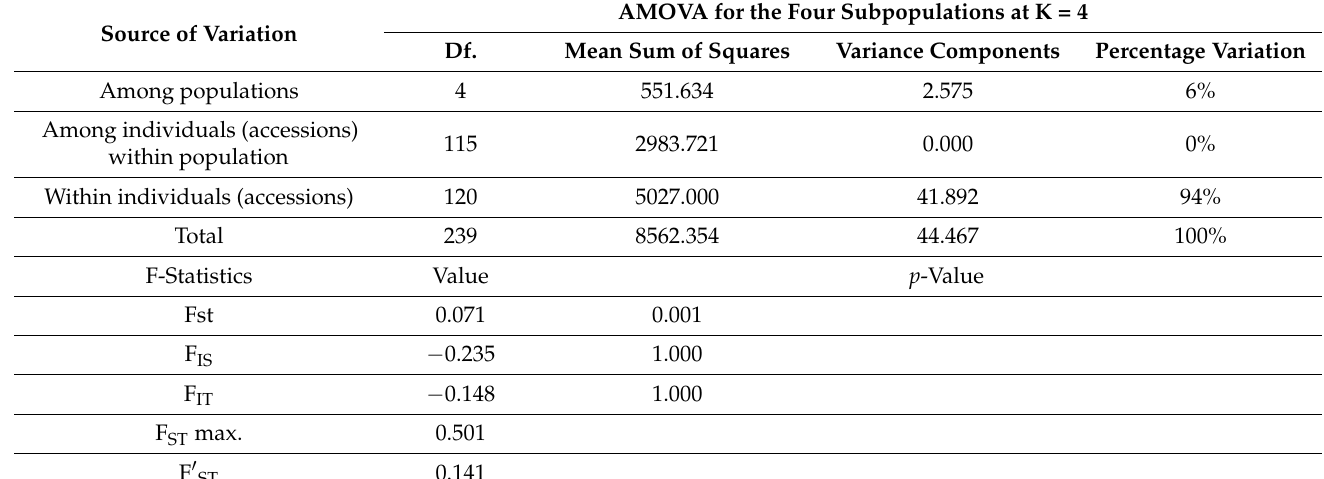
Table 4. Analysis of molecular variance (AMOVA) of the sub-populations of the panel population for the antioxidant traits in the 120 rice